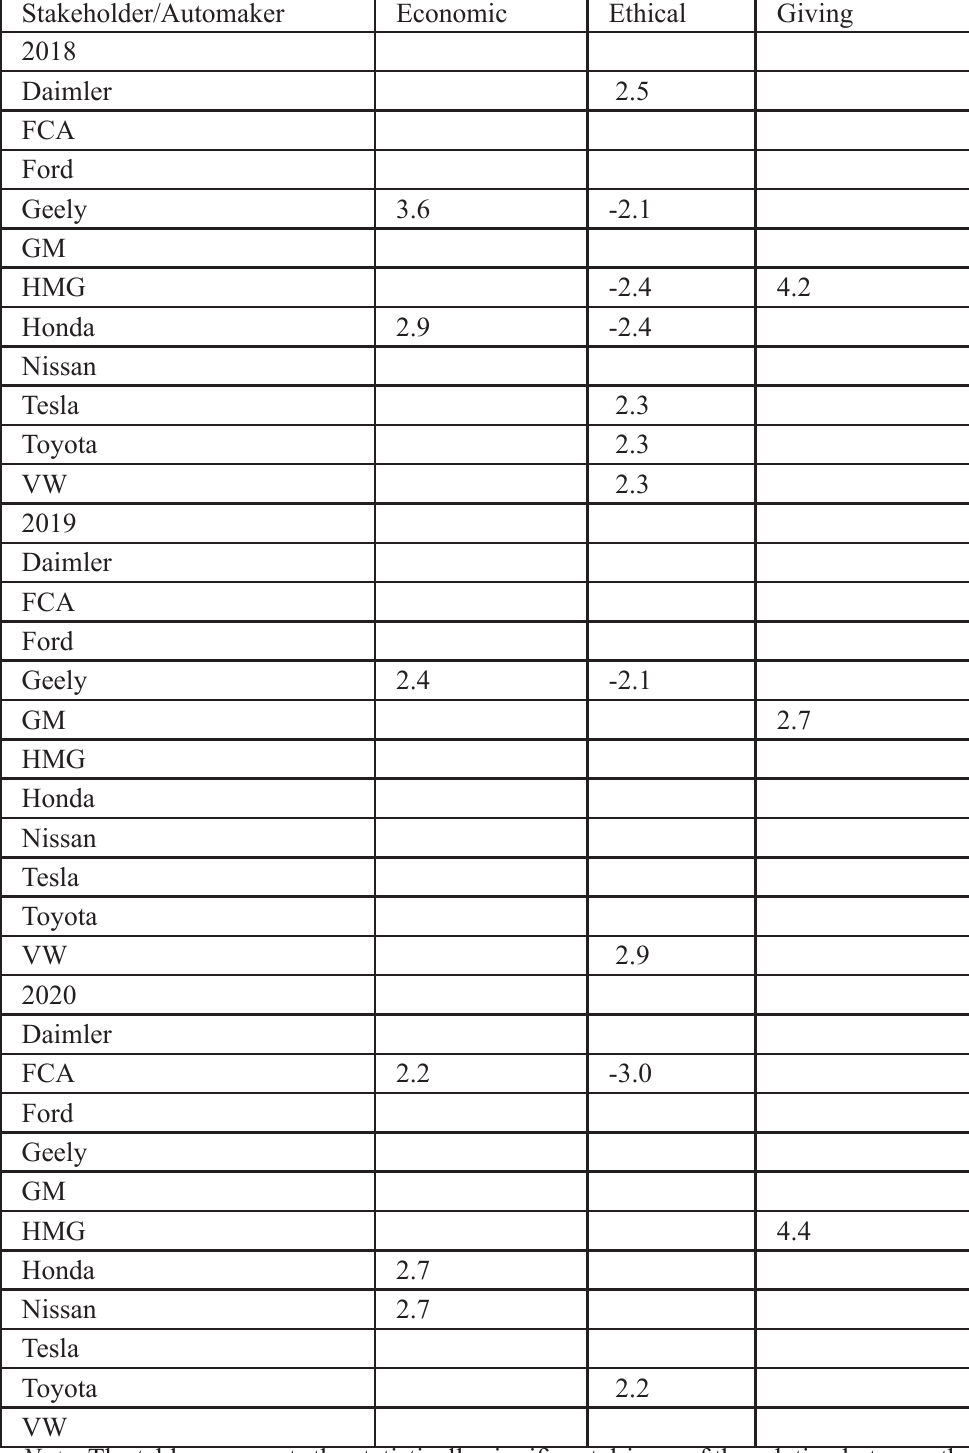
Note: The table represents the statistically significant drivers of the relation between the two variables by year at p <